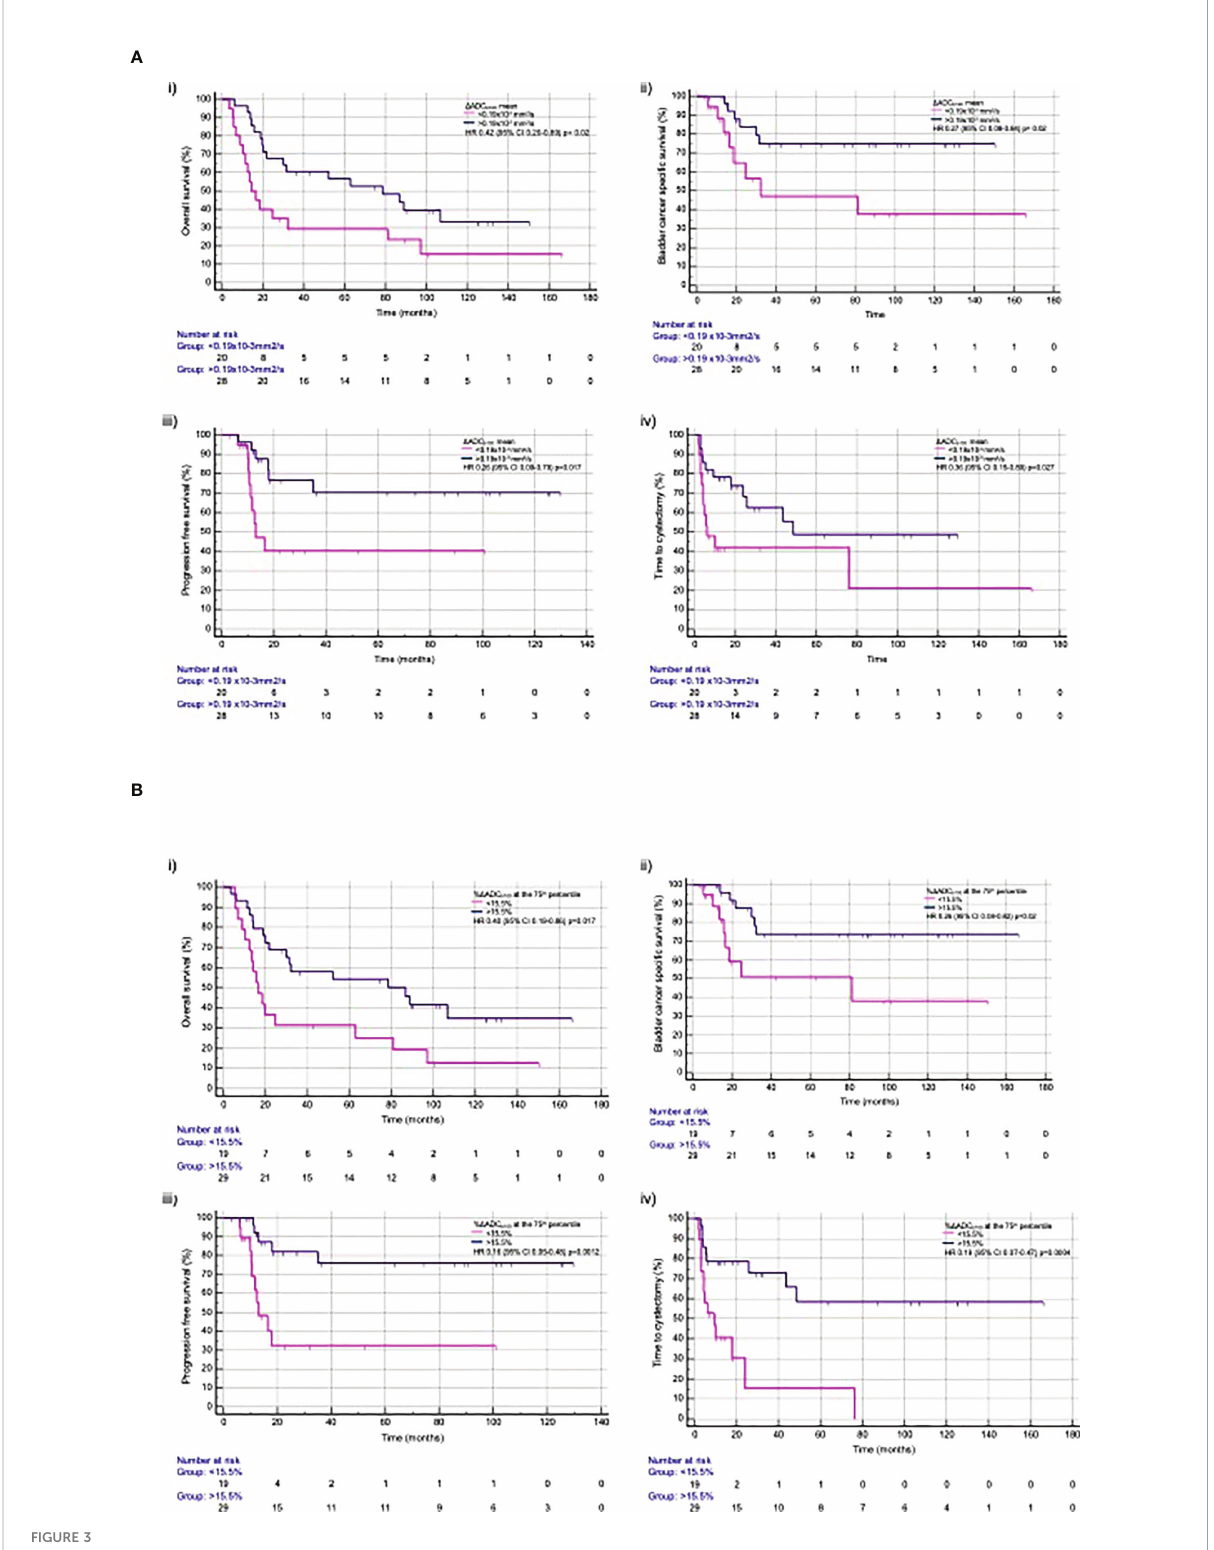
FIGURE 3 Time to event outcomes with (A) D ADC b100 mean and (B) % D ADC b100 at the 75th percentile for (i) overall survival, (ii) bladder cancer speci fi c free survival, (iii) progression-free survival, and (iv) time to